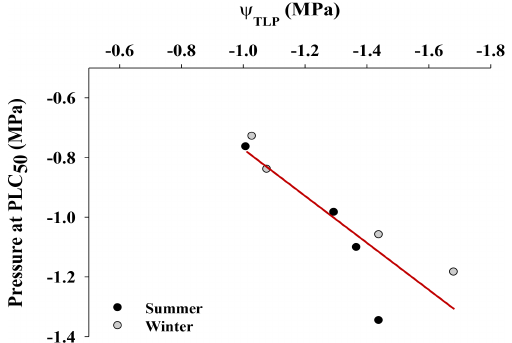
Figure 9. Co-ordination in the response of a leaf-scale and branch- scale trait and drought sensitivity. From Zolfaghar